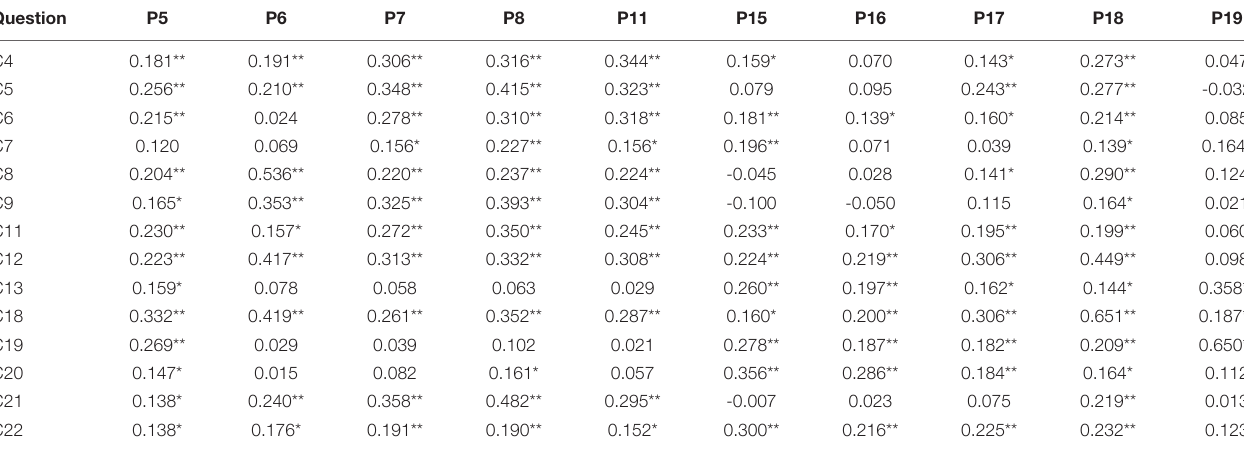
TABLE 3 | Matrix of correlations between parental answers (P) and young basketball players’ answers (C).